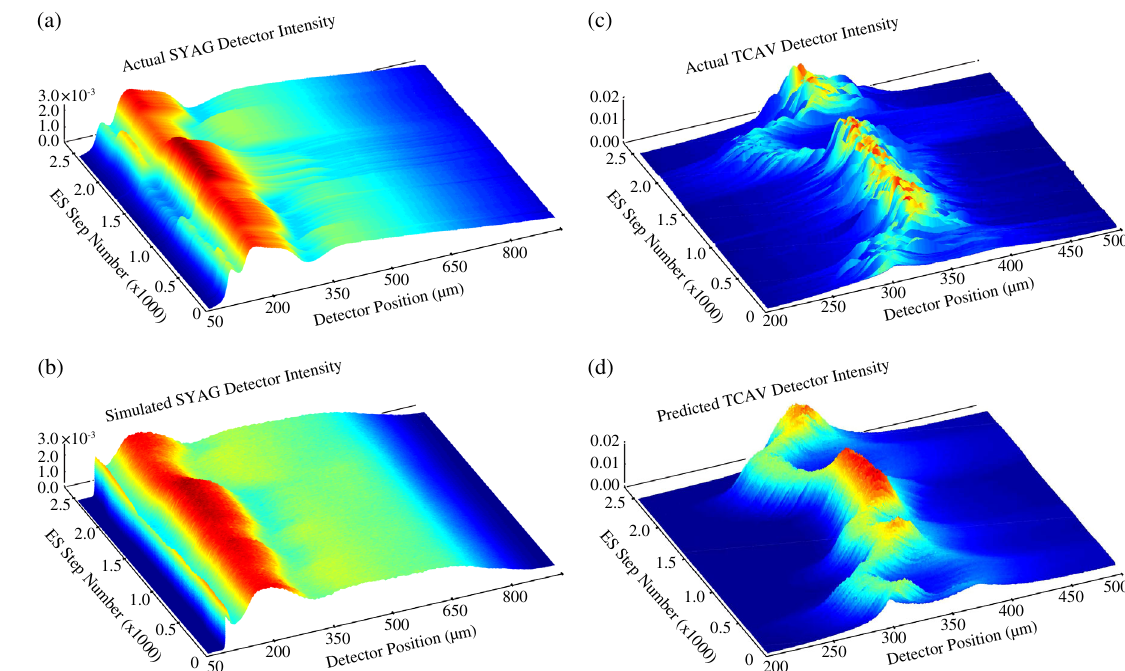
FIG. 5. (a) The energy spectrum, which is always available as a nondestructive measurement, was detected and imported into L i T rack ES in order to calculate a cost on which the adaptive convergence was based. (b) L i T rack ES was able to adaptively tune parameters ˆ p order to track the detected energy spectrum with the simulated spectrum. (c) The TCAV was on and recording the longitudinal beam profile during the adaptive process, these values were not used as inputs to L i T rack ES , but were detected in order to measure the predictive performance of L i T rack ES . (d) Based only on energy spectrum readings, L i T rack ES was able to predict the longitudinal electron bunch profile, tracking the actual bunch profile measurements with the L i T rack ES output. Color, from blue to red, indicates increasing detected intensity.